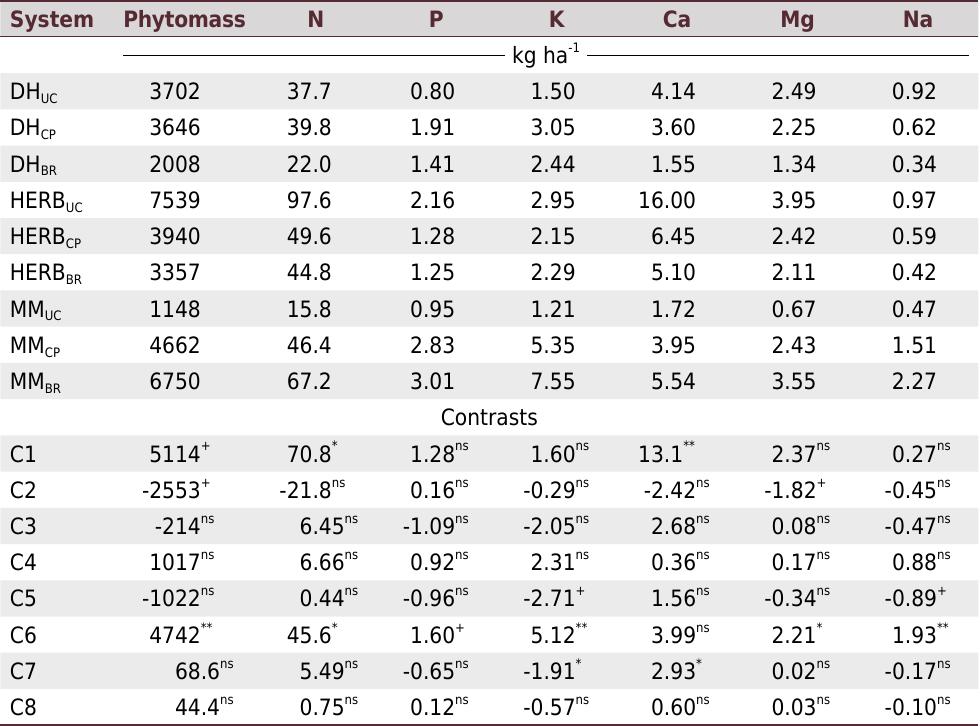
ns , * , ** , + : not significant, significant at 5, 1, and 10 % respectively by F-test. C1: herbicide vs (Mechanical mowing + Disc harrowing) under the cashew canopy; C2: mechanical mowing vs Disc harrowing, under the cashew canopy; C3: herbicide vs (Mechanical mowing + Disc harrowing) at the limit of the cashew canopy projection; C4: mechanical mowing vs Disc harrowing, at the limit of the cashew canopy projection; C5: herbicide vs (Mechanical mowing + Disc harrowing) between the rows of cashew; C6: mechanical mowing vs Disc harrowing, between the rows of cashew; C7: Canopy vs Canopy projection + Between rows; C8: canopy projection vs Between